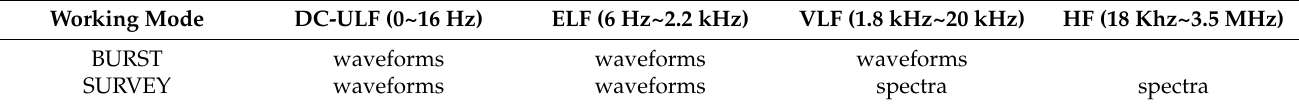
Table 1. Data products under different working modes.